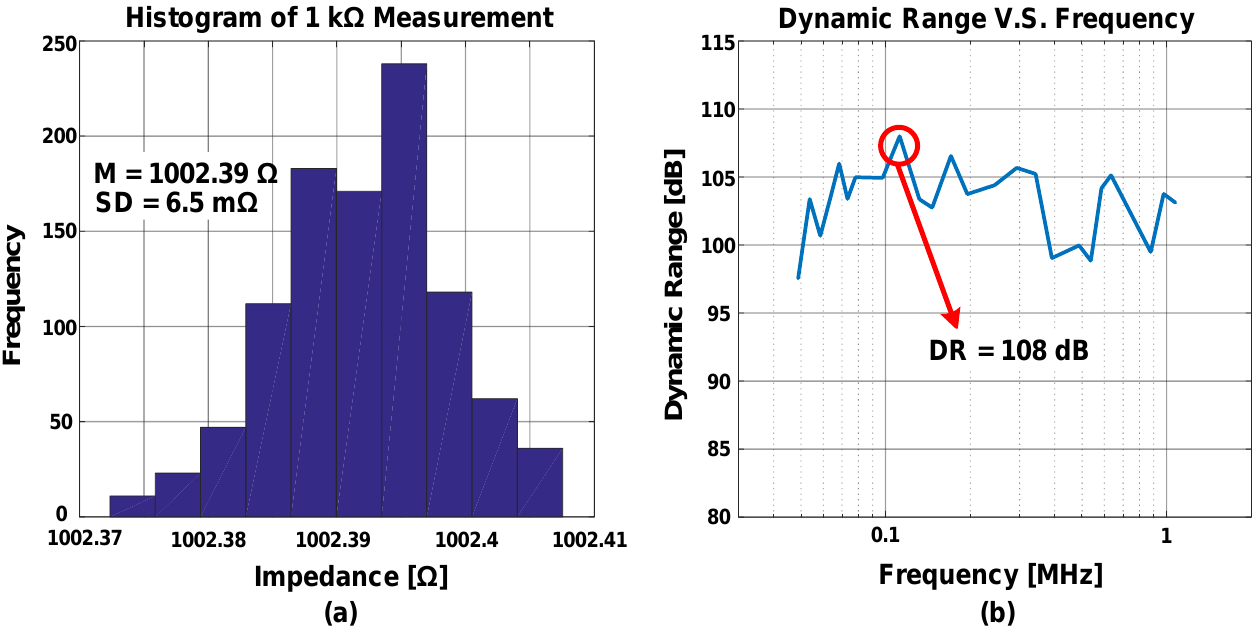
Figure 9. Measurement setup of our EIS system. The performance of this EIS was measured for a 1 kΩ target reference resistor. Shown in Figure 10a, the measured histogram of the digital output after the digital post-processing reveals that the RMS noise is 6.5 mΩ , which corresponds to a dynamic range of 108 dB. Figure 10b shows the result of measuring the dynamic range (DR) over a wide frequency range from 30 kHz to 1.25 MHz. The graph indicates that the worst-case DR is 97 dB, and the peak DR is 108 dB, as shown above. Figure 11 shows the measurement result of a stand-alone ADC mode via 4096-point FFT. Without the digital averaging, the ADC exhibits SNDR of 62.7 dB and SFDR of 80 dB for f in = 473 kHz and f sample = 5 MHz under 1.8 V supply.